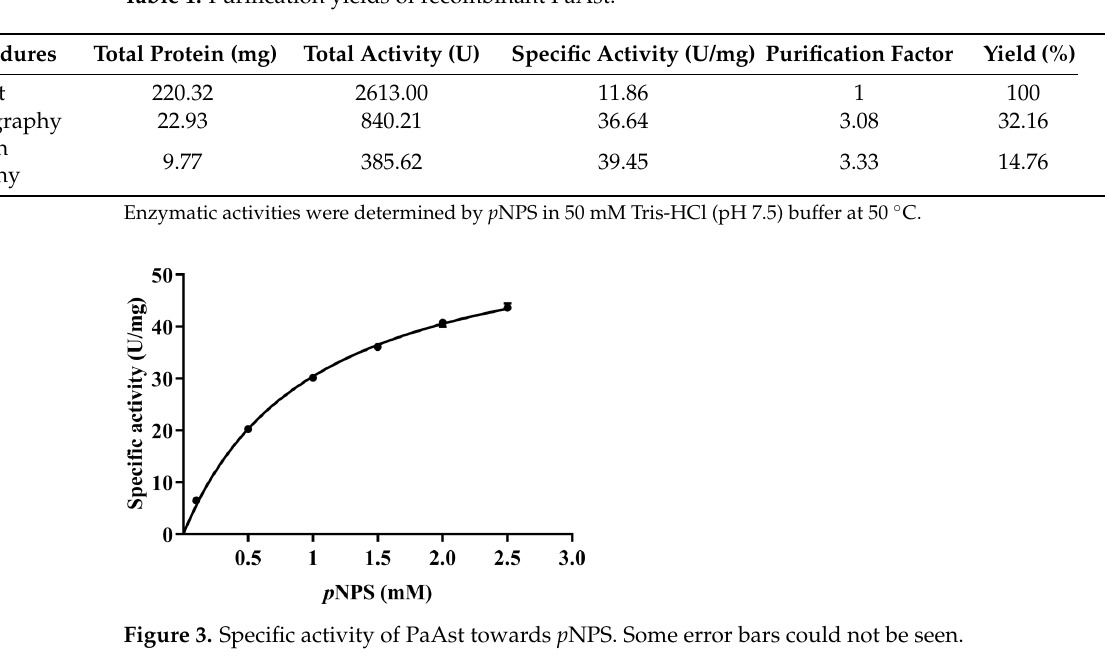
Table 1. Purification yields of recombinant PaAst.